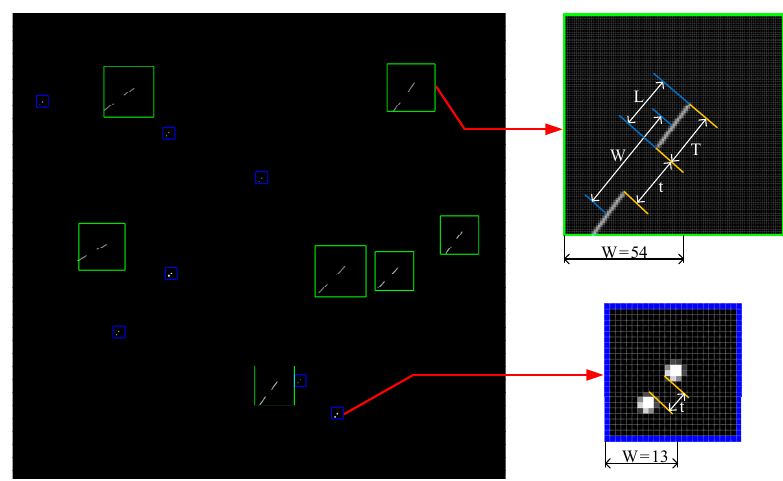
Figure 5. Star images matching.